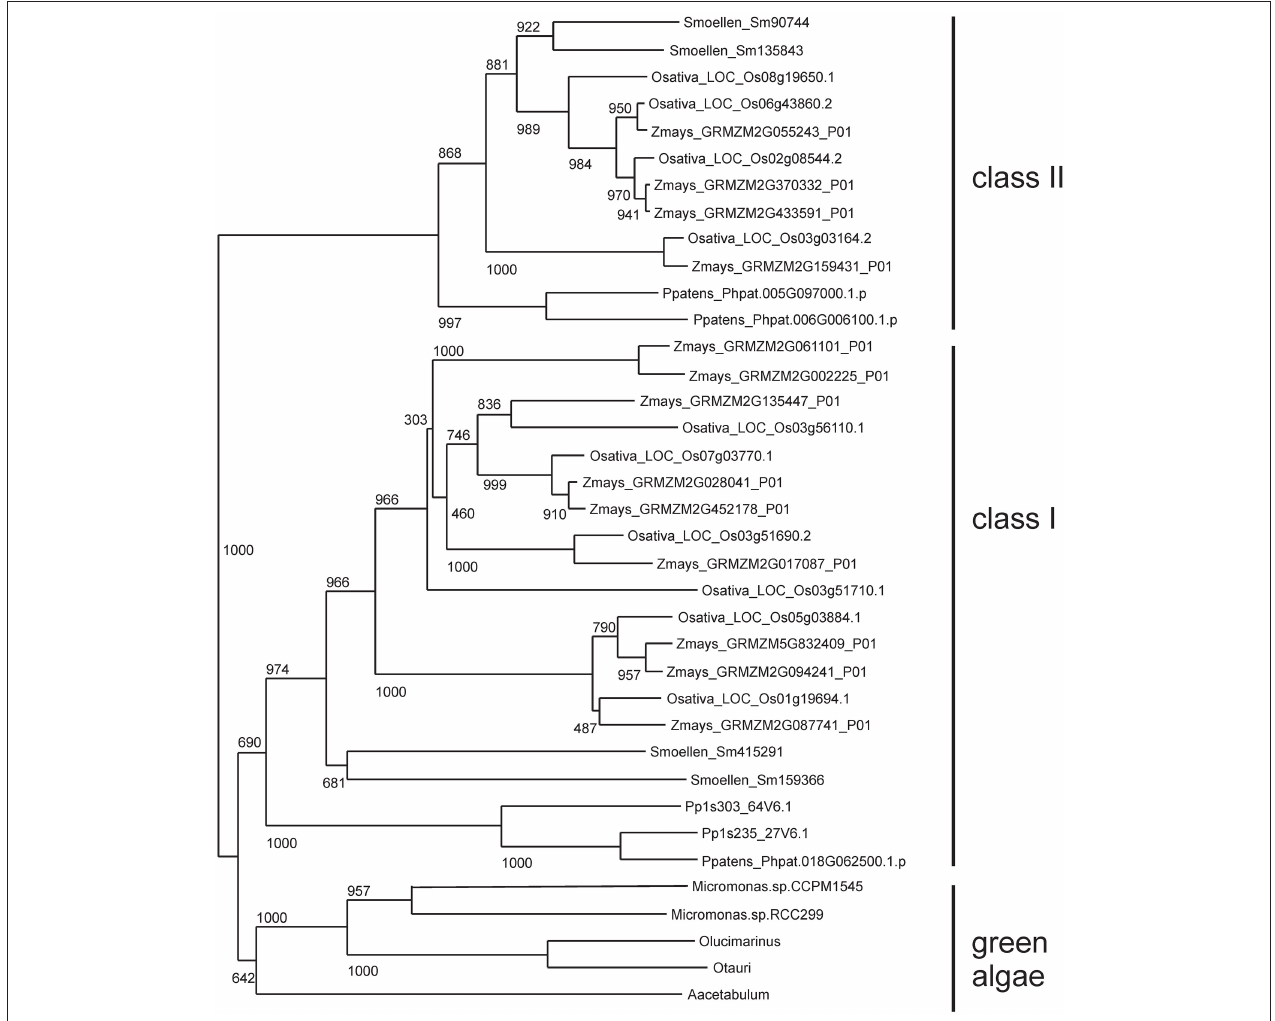
FIGURE 3 | Algae sequences group to classes I KNOX proteins. Grouping of 37 sequences were performed with ClustalW2 using 1000 bootstrap